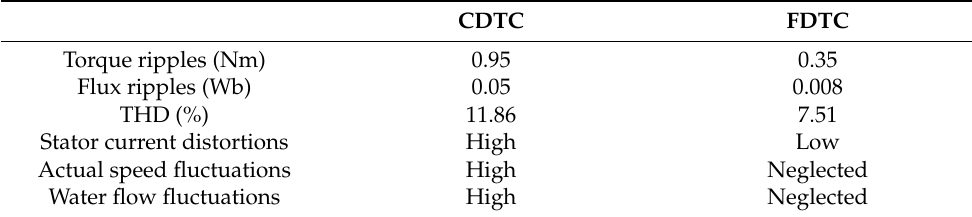
Figure 14. Three-phase stator current for: ( a ) CDTC and ( b ) FDTC.